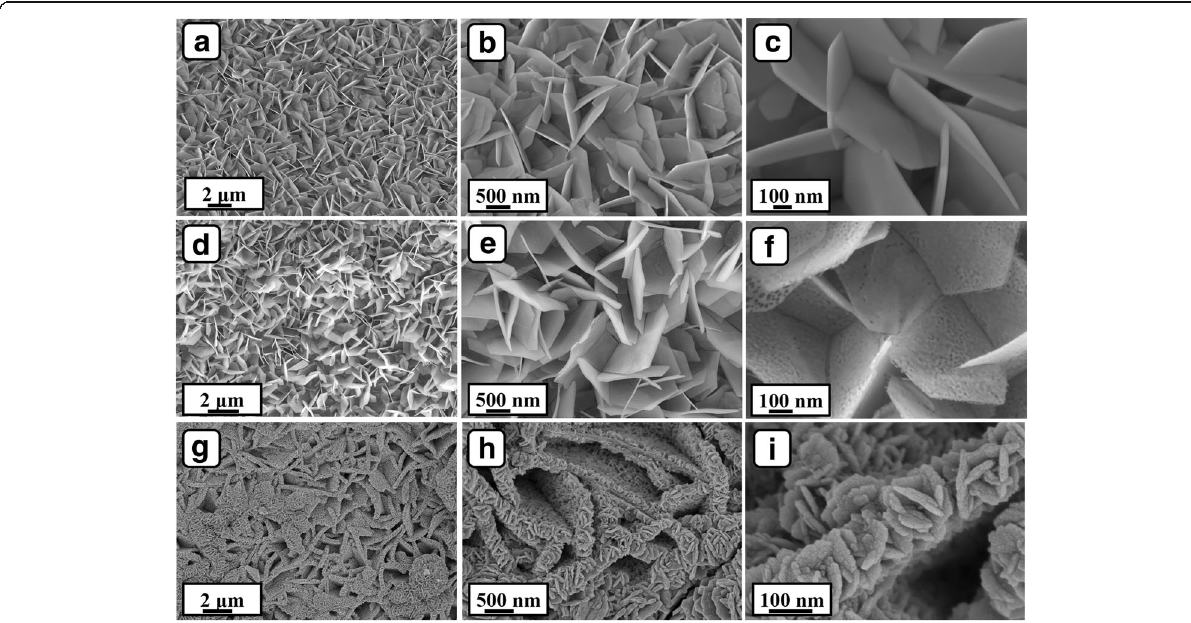
Fig. 3 The SEM images of a – c Ni(OH) 2 flakes/NF, d – f NiO flakes/NF, and g – i NiO flakes@CoMoO 4 NSs/NF with different